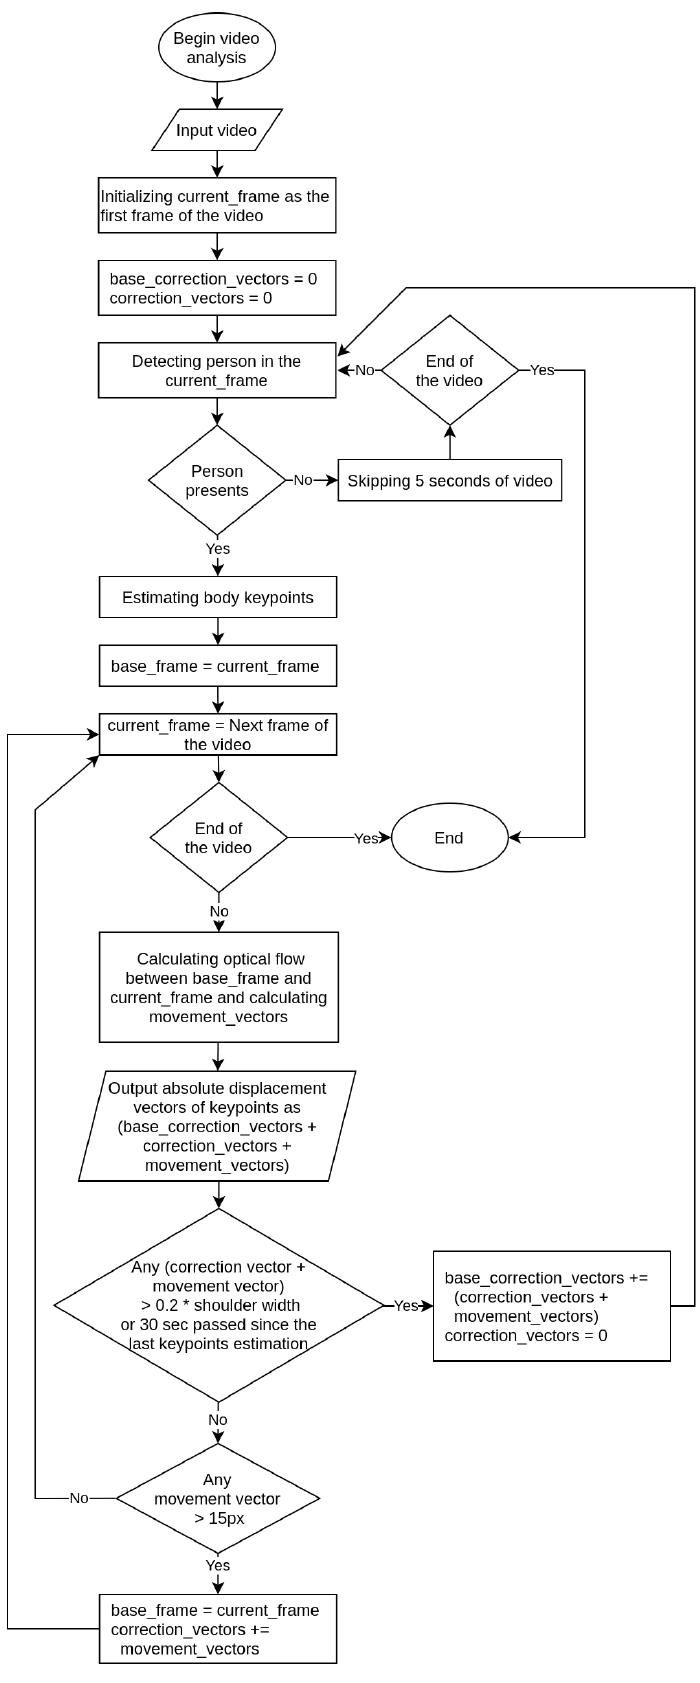
Figure 4. Body parts movement estimation